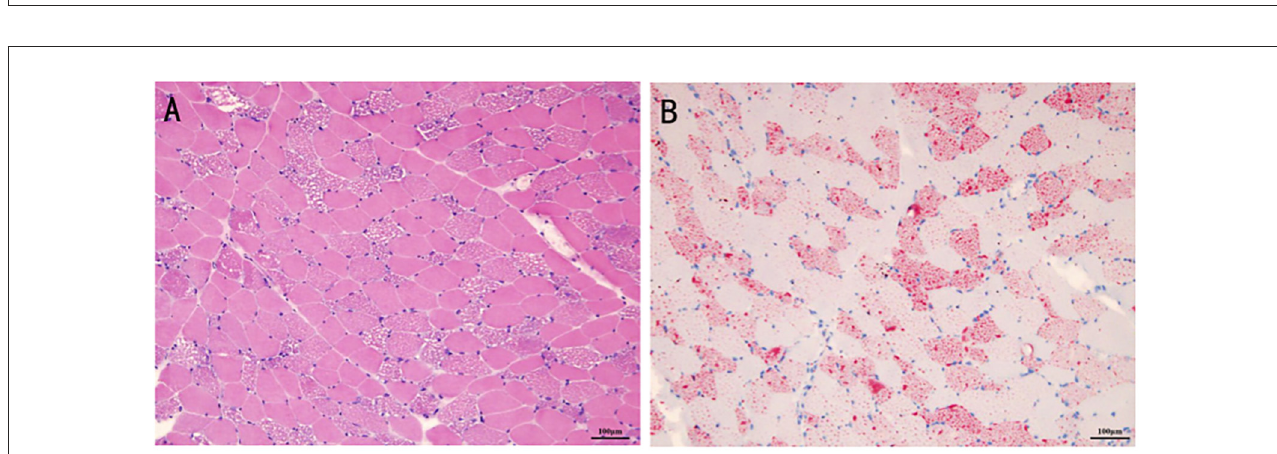
FIGURE2 The histopathologic manifestation of the patient’s muscle. The formation of vacuoles was found in the muscle fibers for hematoxylin-eosin staining (A) . The oil red O staining showed diffuse fat granule aggregation (B) .